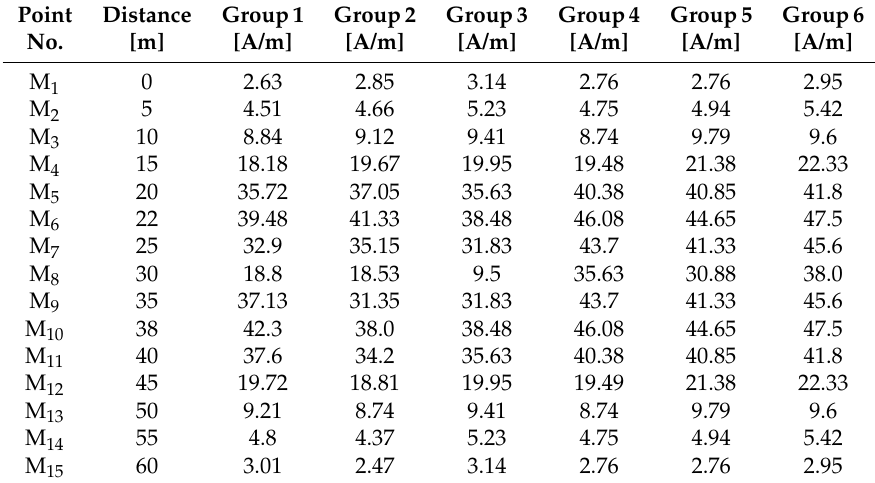
Table 1. The mathematical calculation of the effective values of the magnetic field strength at 1.5 m above the